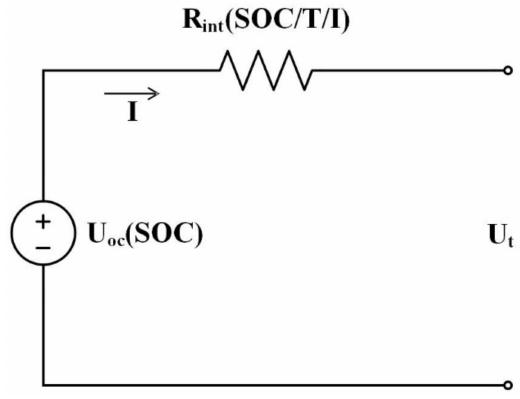
Figure 12. Multi-dependent Rint model [30–32].